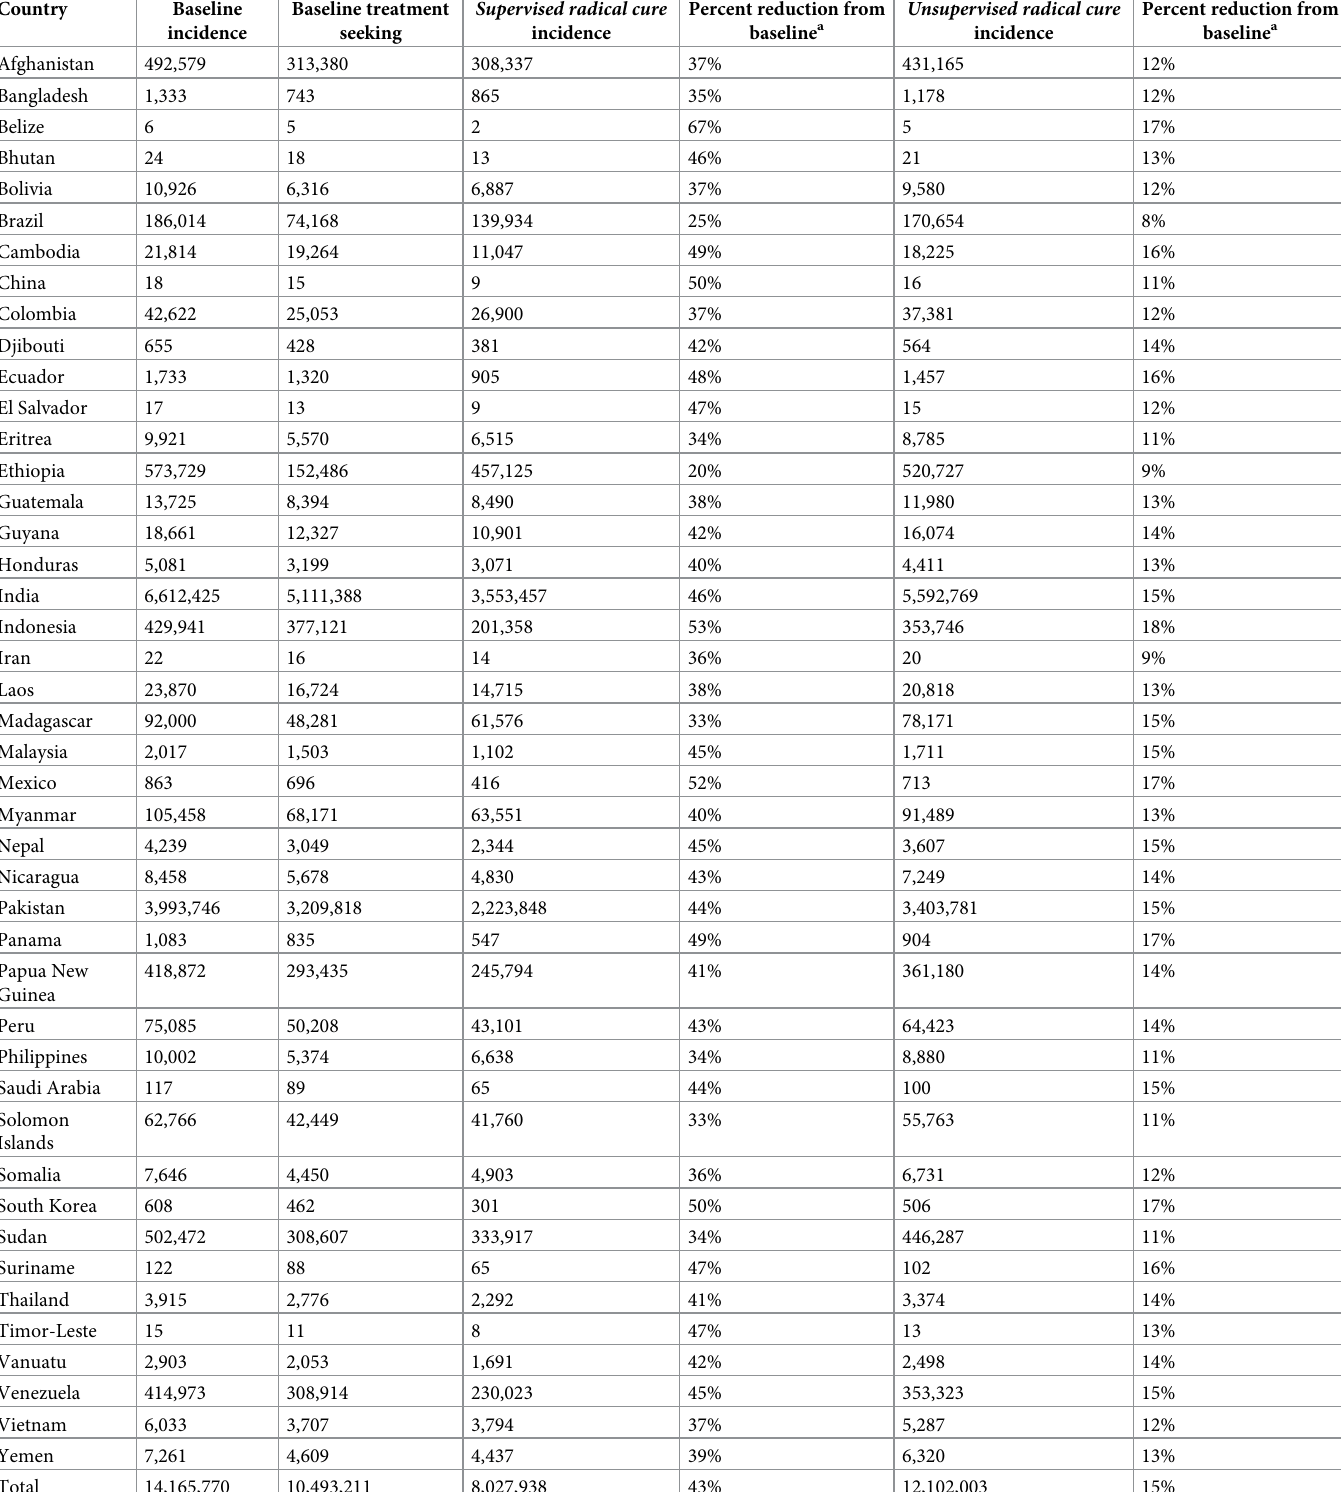
Table 4. Annual incidence of vivax malaria and numbers seeking treatment for the baseline global cost estimates, and annual incidence and percent reduction from the baseline estimates for the Supervised radical cure and Unsupervised radical cure scenarios. Country